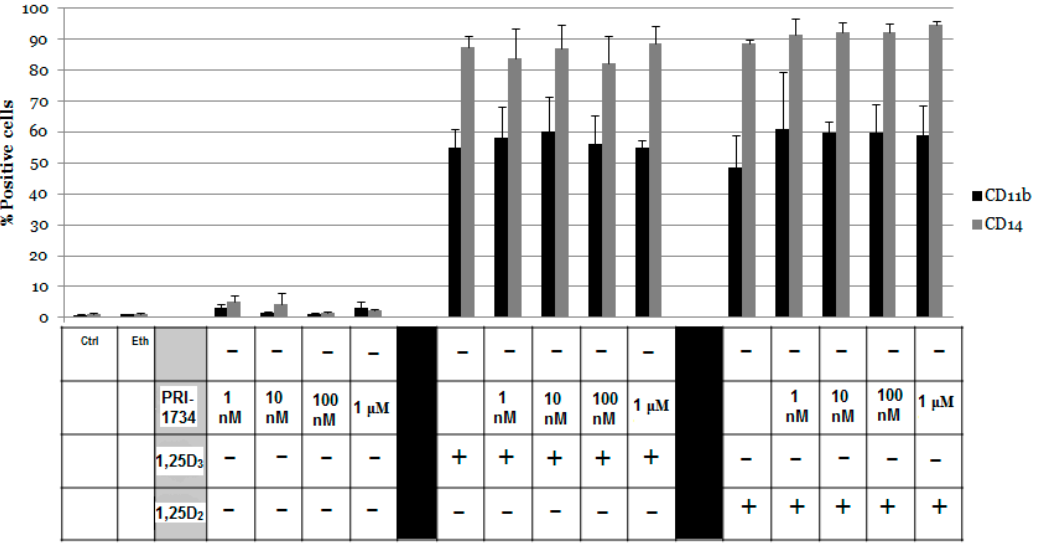
Figure 7. Effect of PRI-1734 in combination with 1,25D 3 or 1,25D 2 on differentiation of HL60 cells. HL60 cells were exposed to 10 nM of either 1,25D 2 or 1,25D 3 in combination with PRI-1734 at different concentrations of: 1 nM, 10 nM, 100 nM, and 1 μ M. The expression levels of both CD11b and CD14 were studied. Percentages of positive cells are presented in the y -axis. Ctrl indicates untreated control cells, Eth indicates ethanol (vehicle) treated control cells.